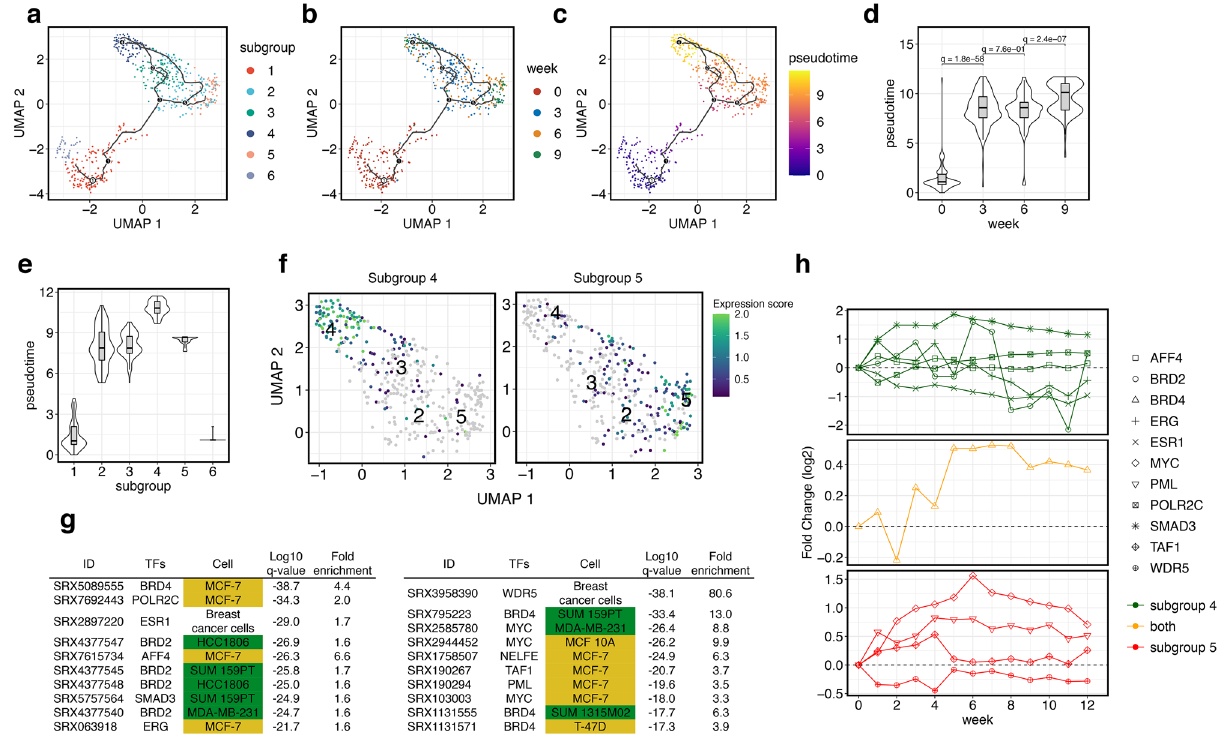
Figure 3. Trajectory analysis of the TAM resistance acquisition process. ( a – c ) Single-cell trajectory during the continuous TAM treatment. Graphs were colored by clusters ( a ), weeks ( b ), and pseudotime ( c ). Numbered circles in white and black indicate a root node and estimated branch nodes in the trajectory, respectively. ( d , e ) Violin plots showing the distribution of pseudotime in each week ( d ) and subgroup ( e ). The q-values in ( d ) are calculated using Wilcoxon rank-sum test. ( f ) Expression score of up-regulated genes in subgroup 4 (left) and subgroup 5 (right), considering the cell trajectory. ( g ) Upstream factor analysis of up-regulated genes displayed in ( f ). Top 10 q-value data are presented. Color represents subtypes of breast cancers: yellow, MCF-7 cells; green, triple-negative breast cancer (TNBC). ( h ) Time-series bulk gene expression patterns listed in ( g ). NELFE was not detected in bulk